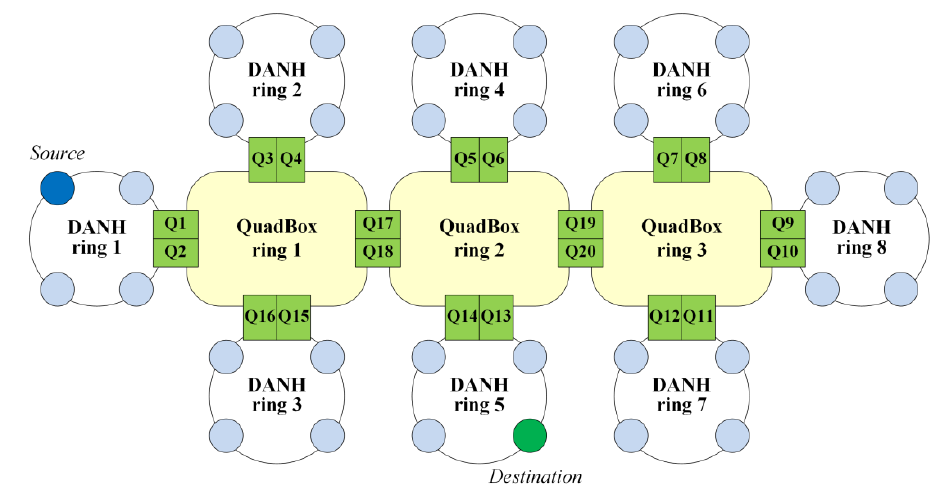
Figure 12. The simulation network.